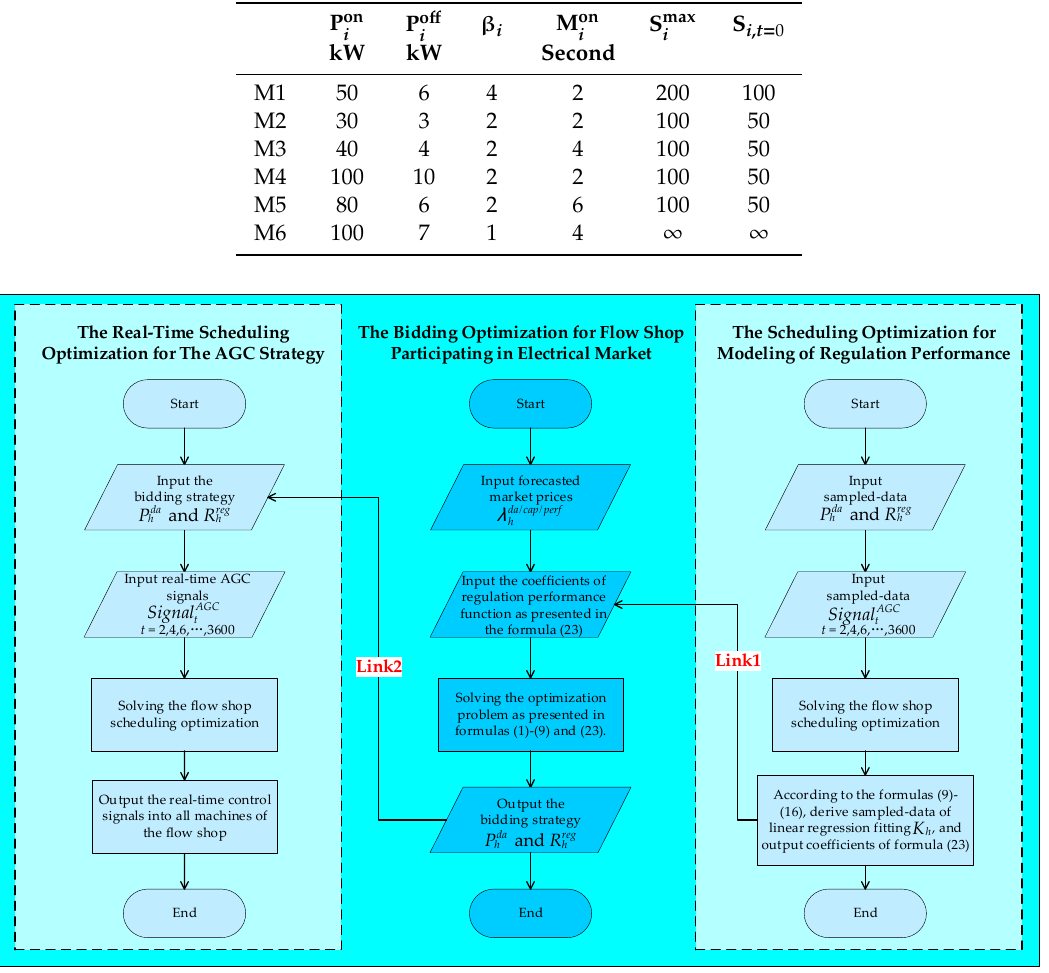
Figure 2. The relationship between the flow shop scheduling optimization and the bidding optimization for flow shops participating in electricity market.